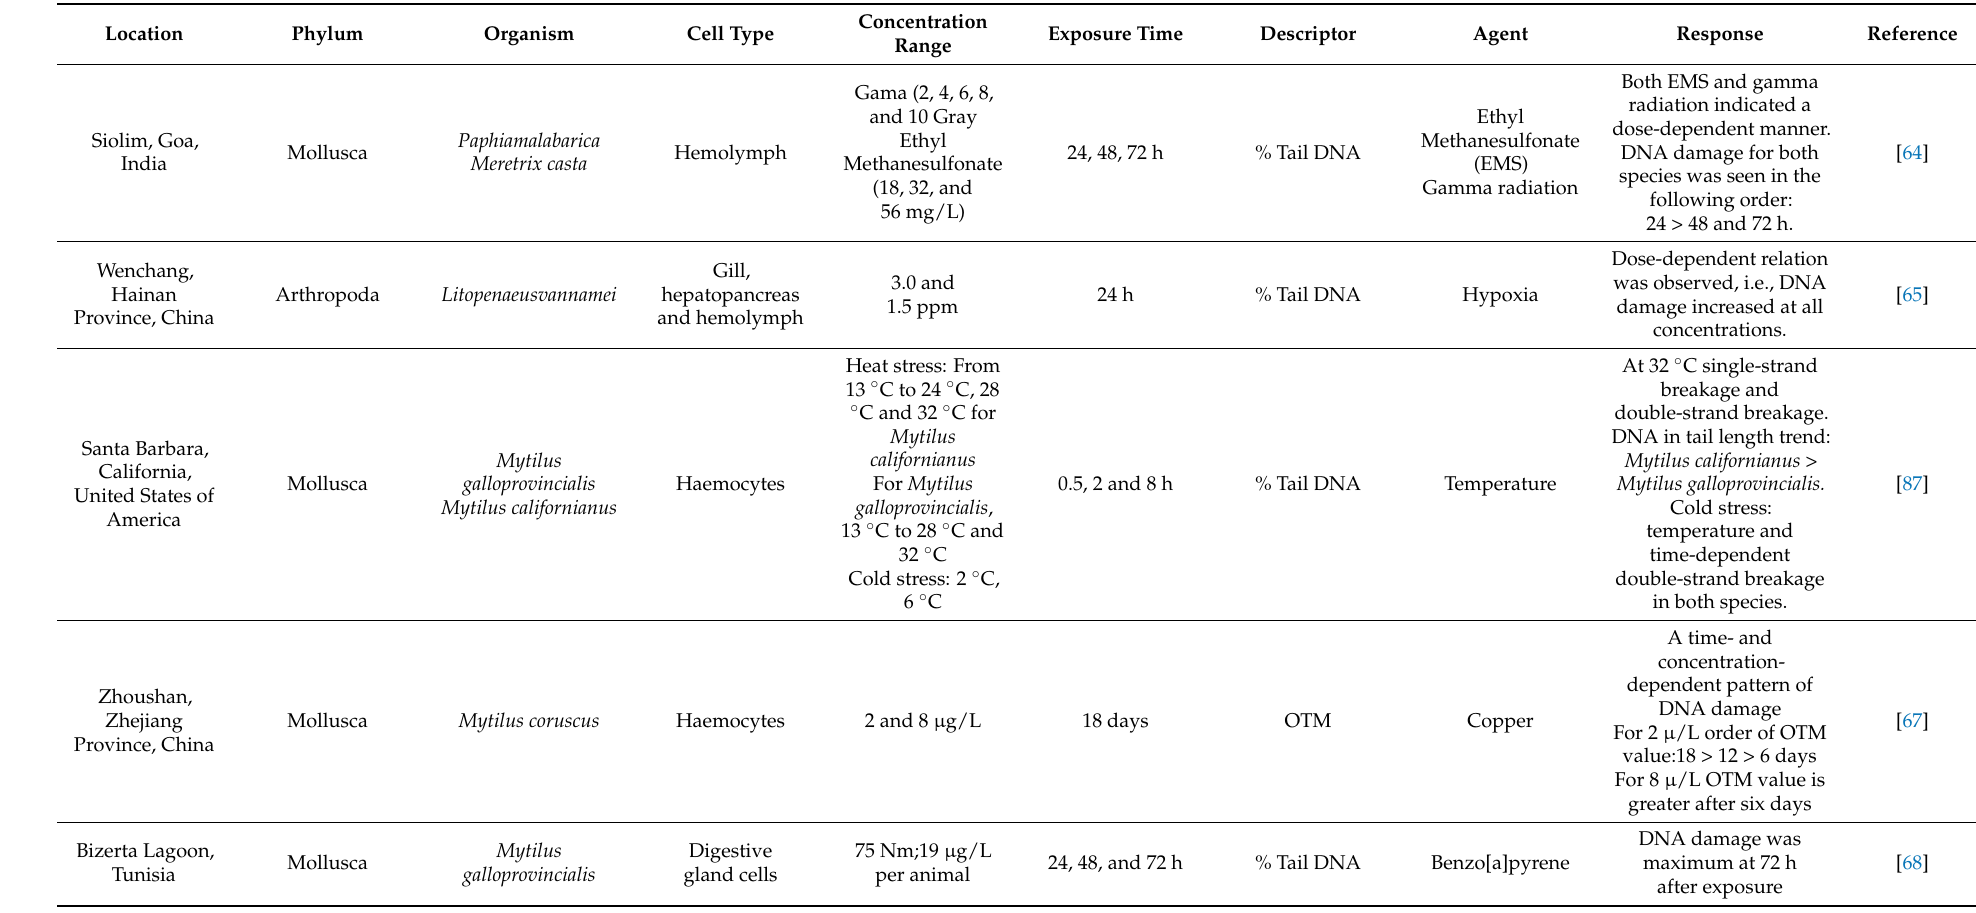
Table 2. Comet test evaluation of DNA damage in aquatic